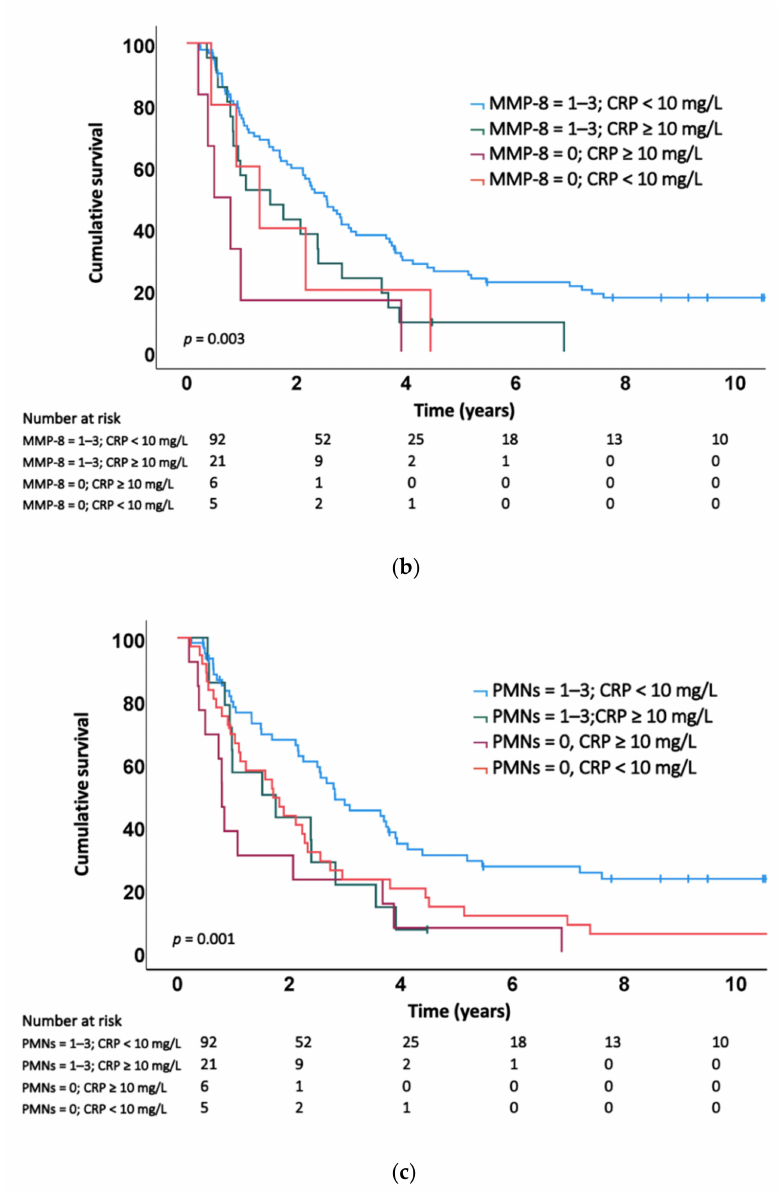
Figure 3. Kaplan–Meier curves. ( a ) Survival in all patients, grouped by matrix metalloproteinase 8 (MMP-8) expression in cancer cells ( p = 0.005); ( b ) survival in all patients, grouped by MMP-8 expression in cancer cells and plasma C-reactive protein (CRP) level ( p = 0.003); ( c ) survival in all patients, grouped by MMP-8 positive polymorphonuclear cell (PMN) presence in the tumour and plasma CRP level ( p =